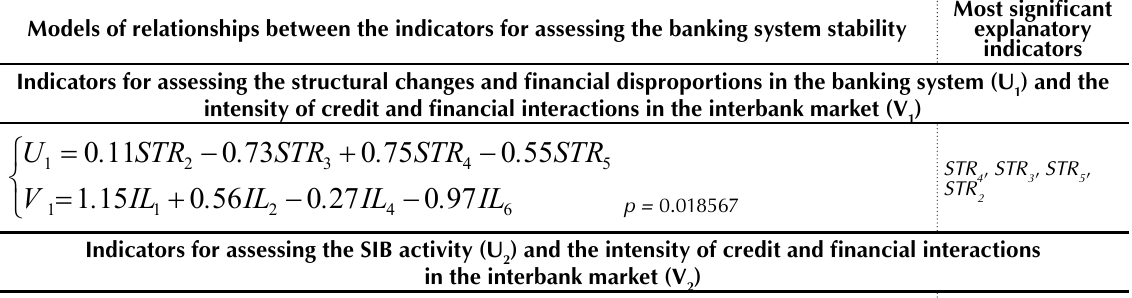
) and the intensity of credit and financial interactions 2 in the interbank market (V ) 2 SIB , SIB 3 4 p = 0.013568 ) and the 3 foreign exchange regulation effectiveness (V ) 3 IL , IL 6 1 ) and the 4 effectiveness of the money turnover regulation (V ) 4 IL , IL 5 3 ) and the 5 state of the bank lending to the economy (V ) 5